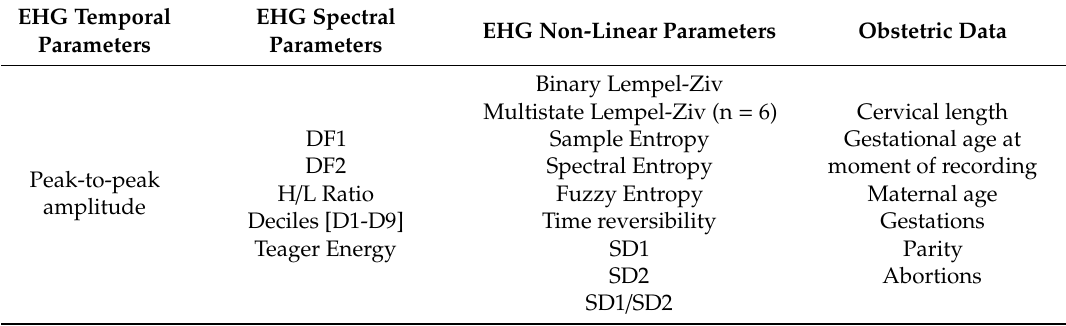
Table 1. Summary of di ff erent EHG features and obstetric